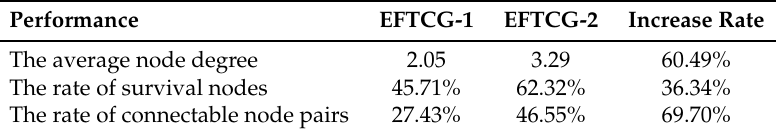
Table 2. The average improvement of fault tolerance.